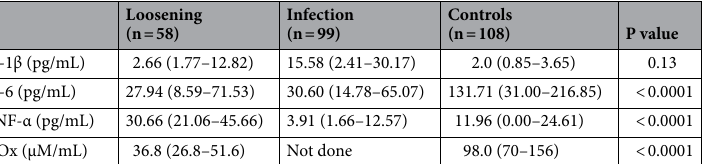
Table 3. Cytokine and nitric oxide (NOx) plasma levels in patients with prosthesis loosening, infection and controls.